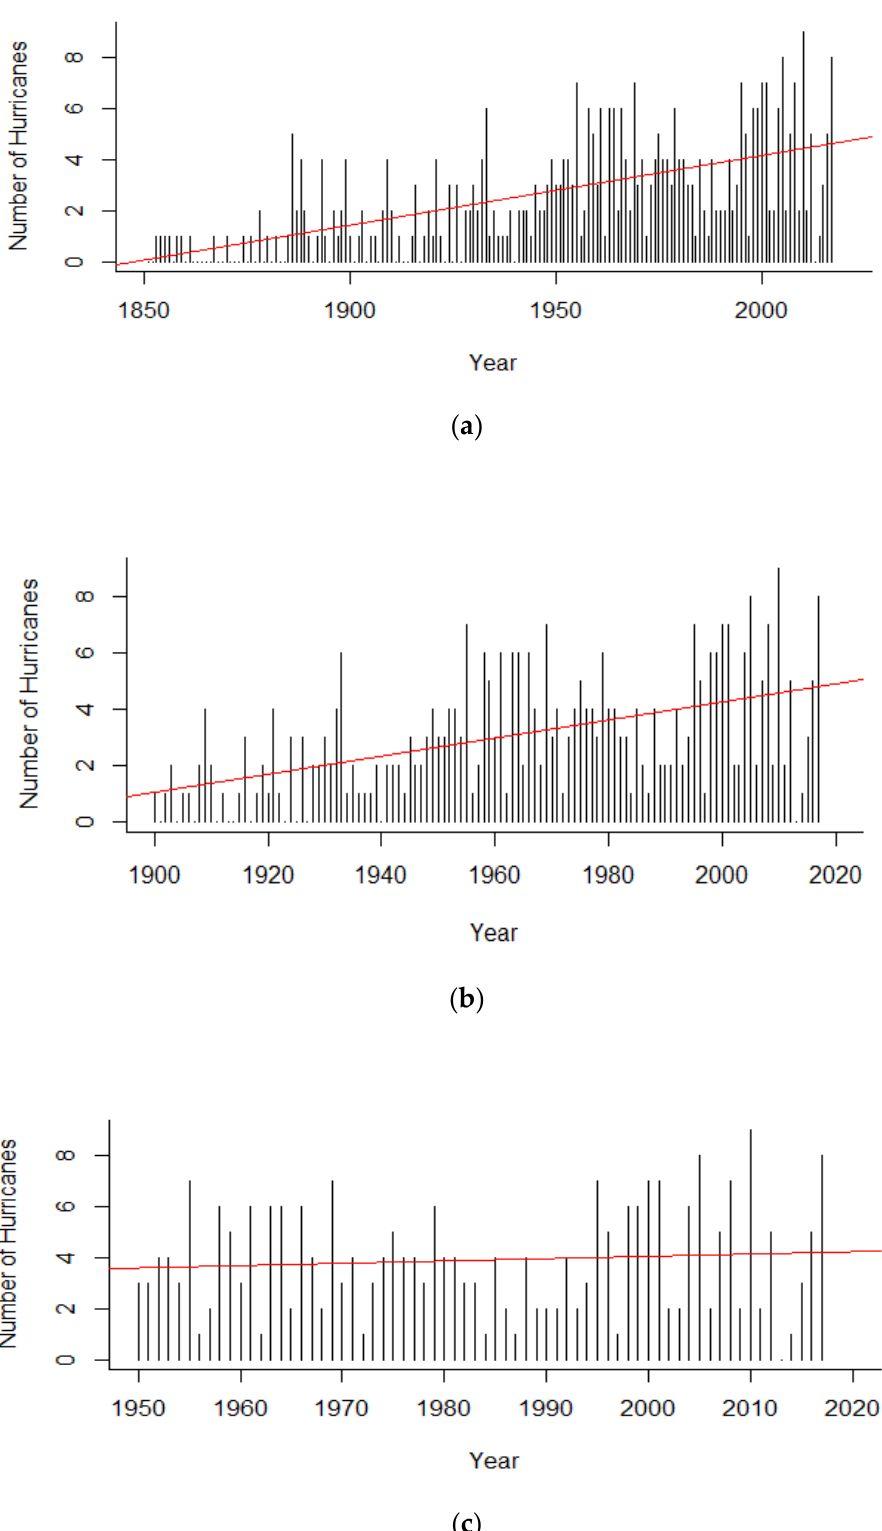
Figure 4. Histograms of rapidly intensifying hurricane counts per year from ( a ) 1851 – 2017, ( b ) 1900 – Figure4. Histogramsofrapidlyintensifyinghurricanecountsperyearfrom( a )1851–2017, ( b )1900–2017, and ( c ) 2017, and ( c ) 1950 – 2017. Table 4. Time series count model coefficients and confidence intervals within a Poisson distribution.